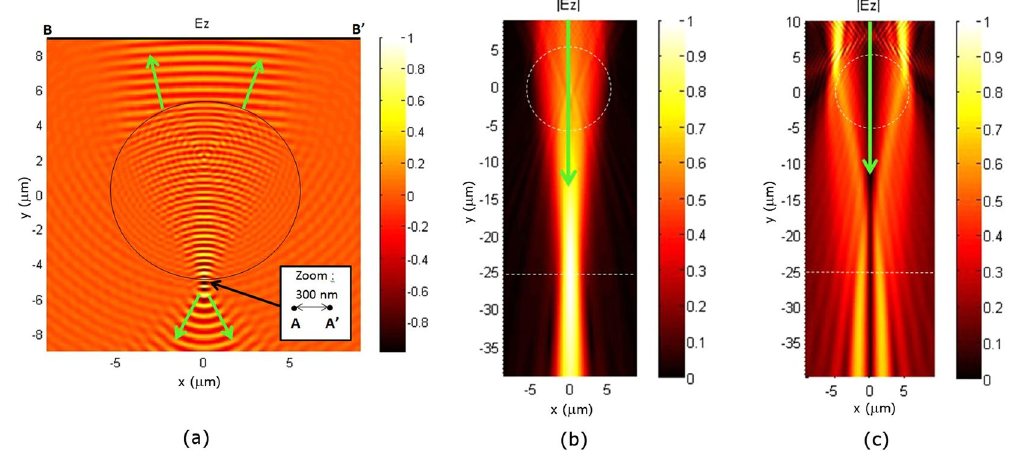
Figure 2. Attempts to predict the performance of the microsphere assisted interferometric microscope. The virtual image plane positions (dashed lines) are determined using 2D FEM (TE wave case) simulations for an 11 µ m microsphere (n = 1.68) and light at a wavelength of λ = 600 nm. The arrows indicate the direction of light propagation. ( a ) Electric field (real part) propagation from two point sources A and A’ that are in phase, separated by 300 nm, and positioned below the microsphere in the plane at y = − 5.5 µ m. ( b ) Time-reversal propagation, without the sphere, of the wavefront emanating from [B, B’] in ( a ) (absolute values |E z |). The virtual image plane is 20 µ m below the microsphere. ( c ) As in ( b ) when the two sources A and A’ in ( a ) are out of phase.